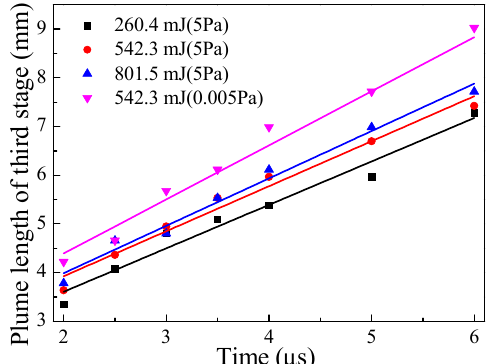
Figure 24. The plume length of third stage variation with time and its linear fitting at different laser energies (ambient pressure 5 Pa and 26.5% Al).